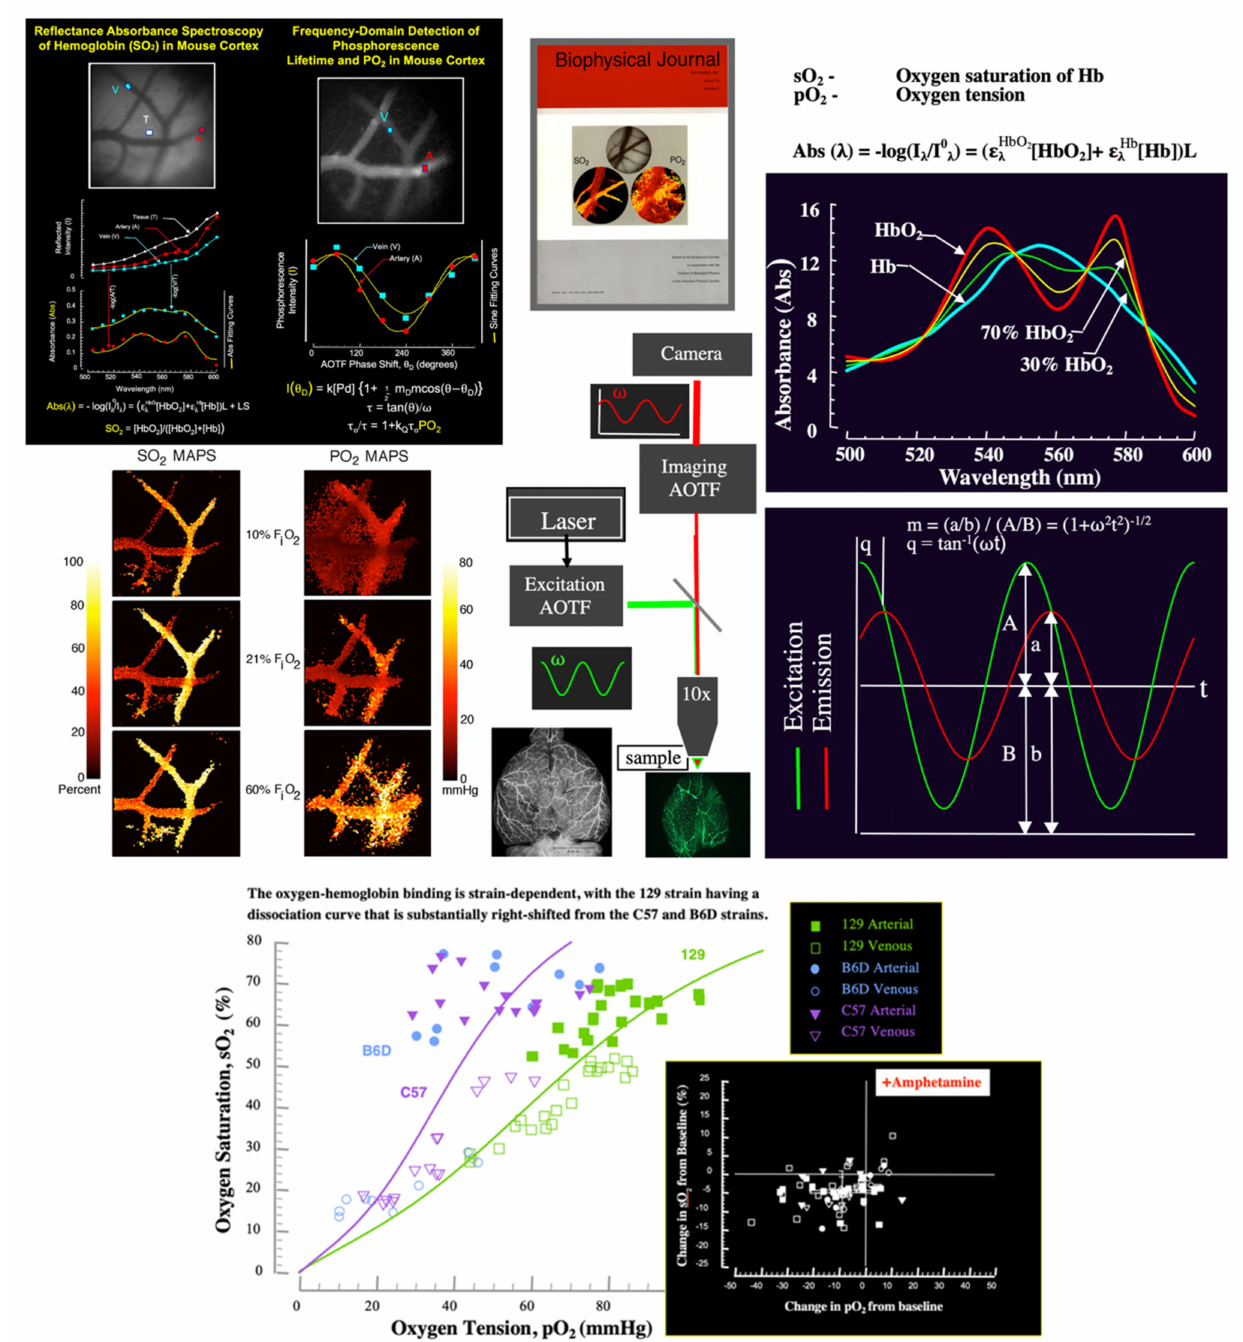
Figure 20. Simultaneous mapping of oxygen saturation of hemoglobin and oxygen tension [150,151]. Method schematics ( top , right ); arteries and veins could easily be distinguished and changed upon inhalation O 2 concentration being changed ( top , left ). Sigmoidal pO 2 vs. sO 2 curves were obtained, different between mouse lines ( left ). Amphetamine decreased both sO 2 and pO 2